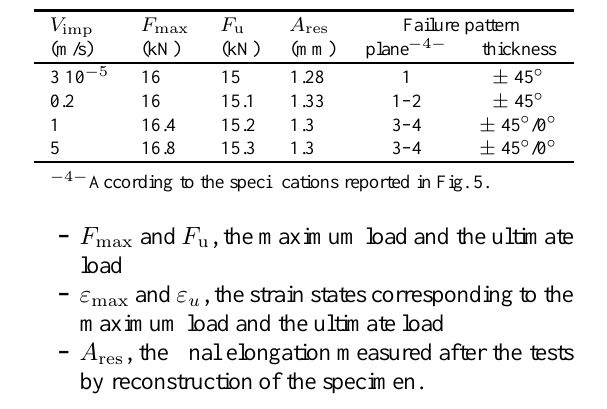
Table 2 Global results of the quasi-static and dynamic tension